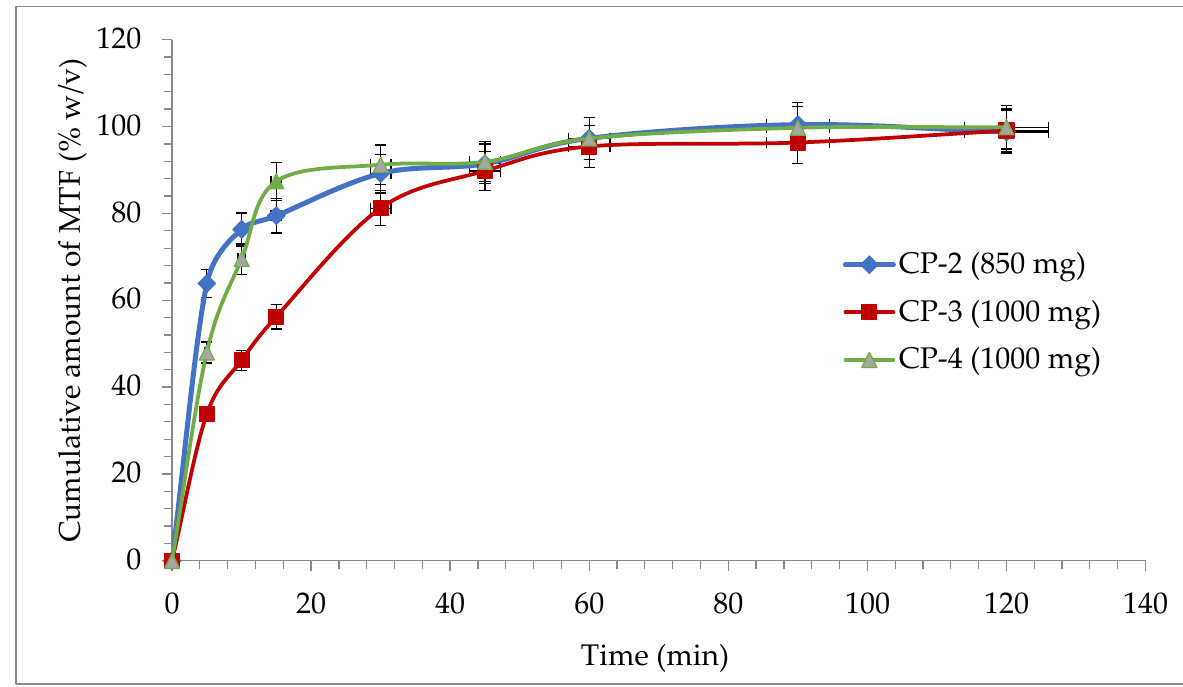
Figure 6. Release profile of M-HCl from conventional tablets.